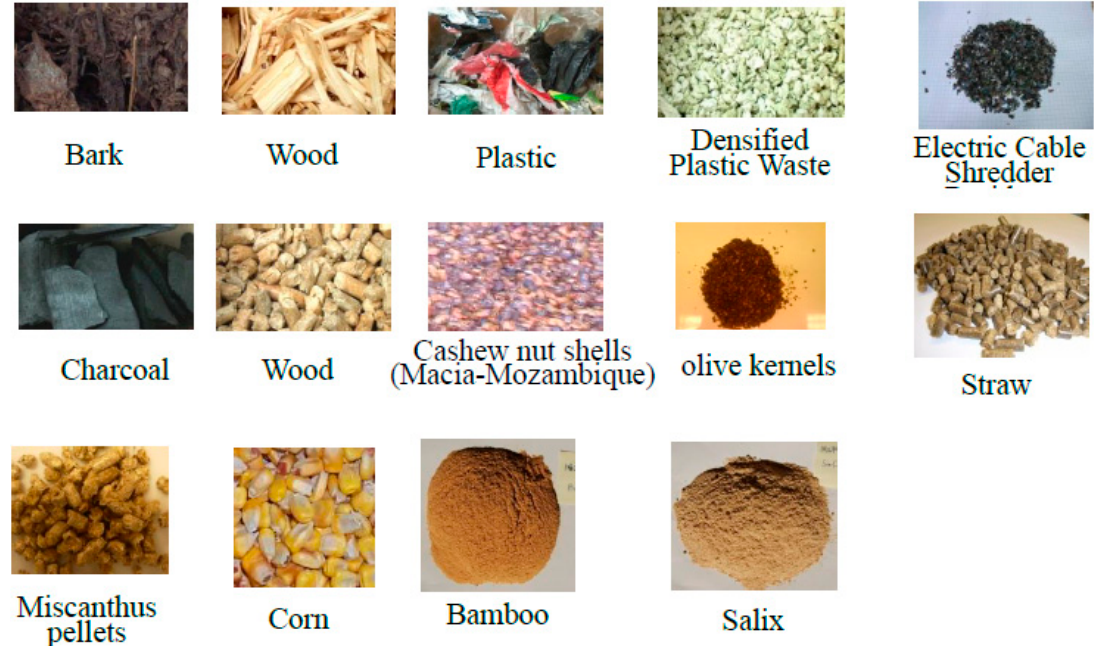
Figure 3. Types of materials used for HiTAG/HiTSG conversions.